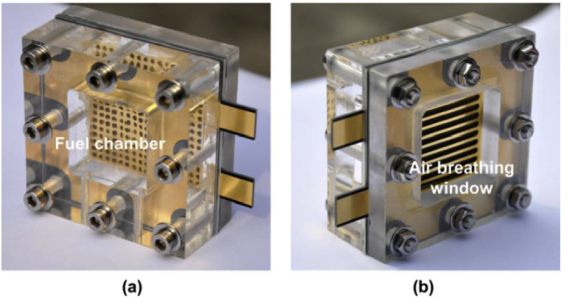
Figure 7. Direct methanol fuel cell: ( a ) fuel chamber with anode; ( b ) air breathing window with the cathode (reprinted from [94], copyright (2015), with permission from Elsevier). As can be seen, the anode and cathode are covered with